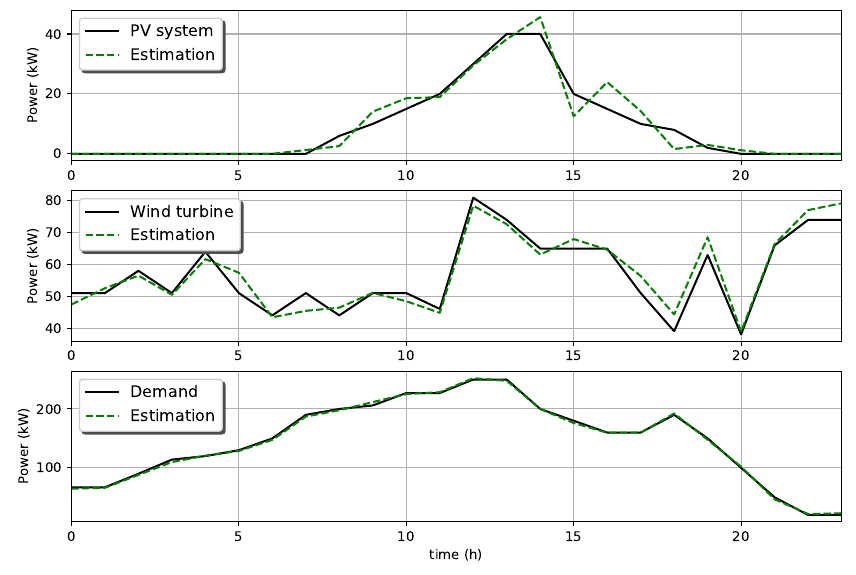
Figure 2. ARMA model estimation of the renewable units generation and the power demanded in the MG for a short time window of 24